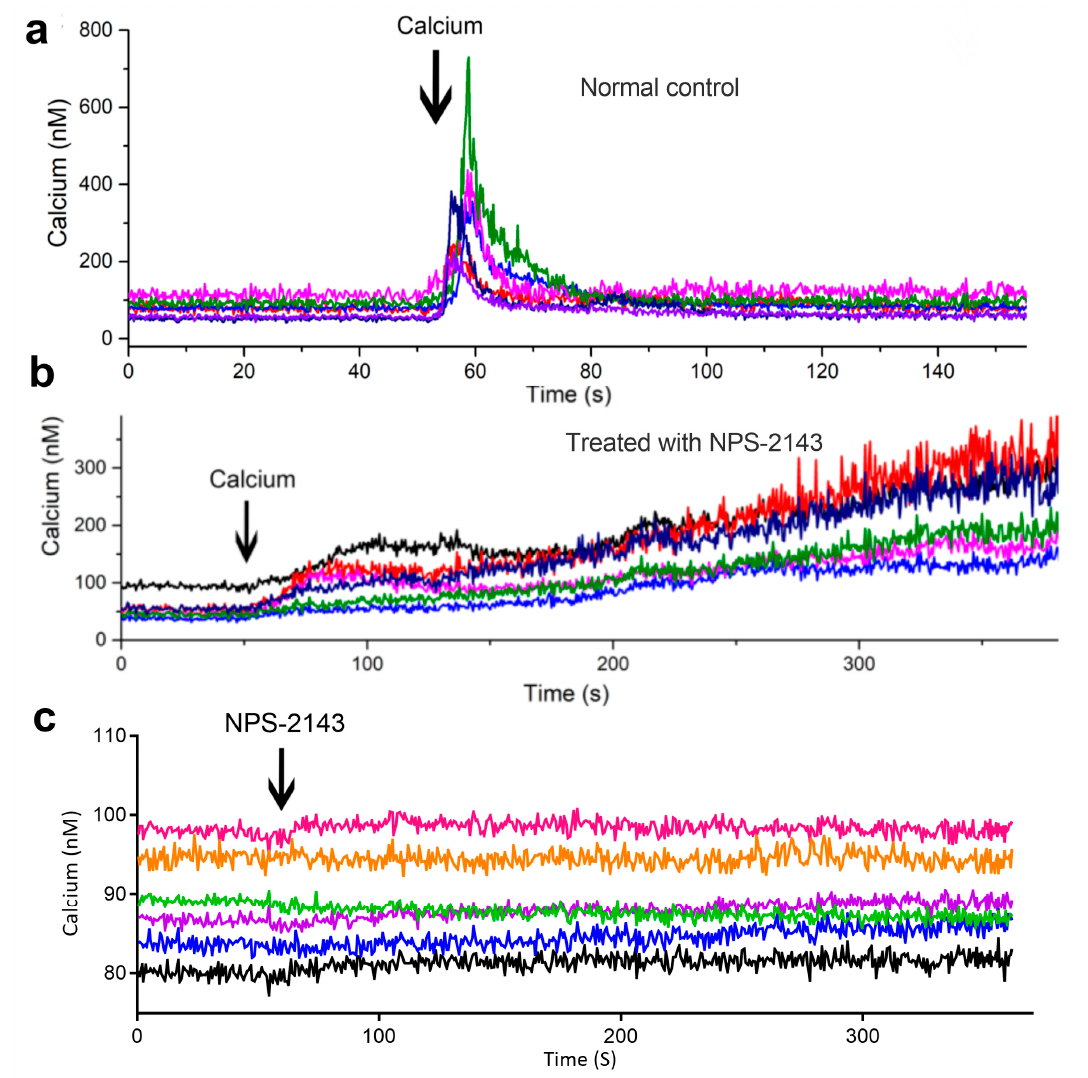
Figure 6. Intracellular calcium transient triggered by extracellular 7.2 mM Ca 2+ in osteoblasts ( a ), treated with NPS-2143 ( b ), and ( c ) NPS-2143 control. Each colored line represents a cell sample.